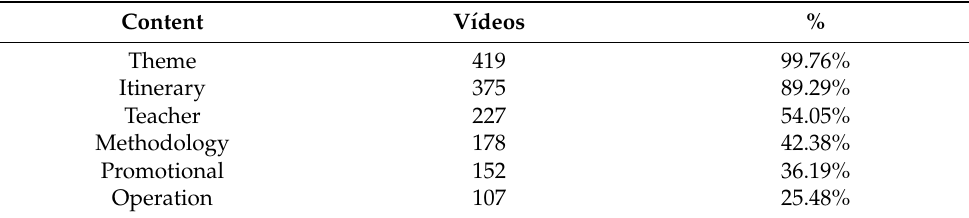
Table 1. Content